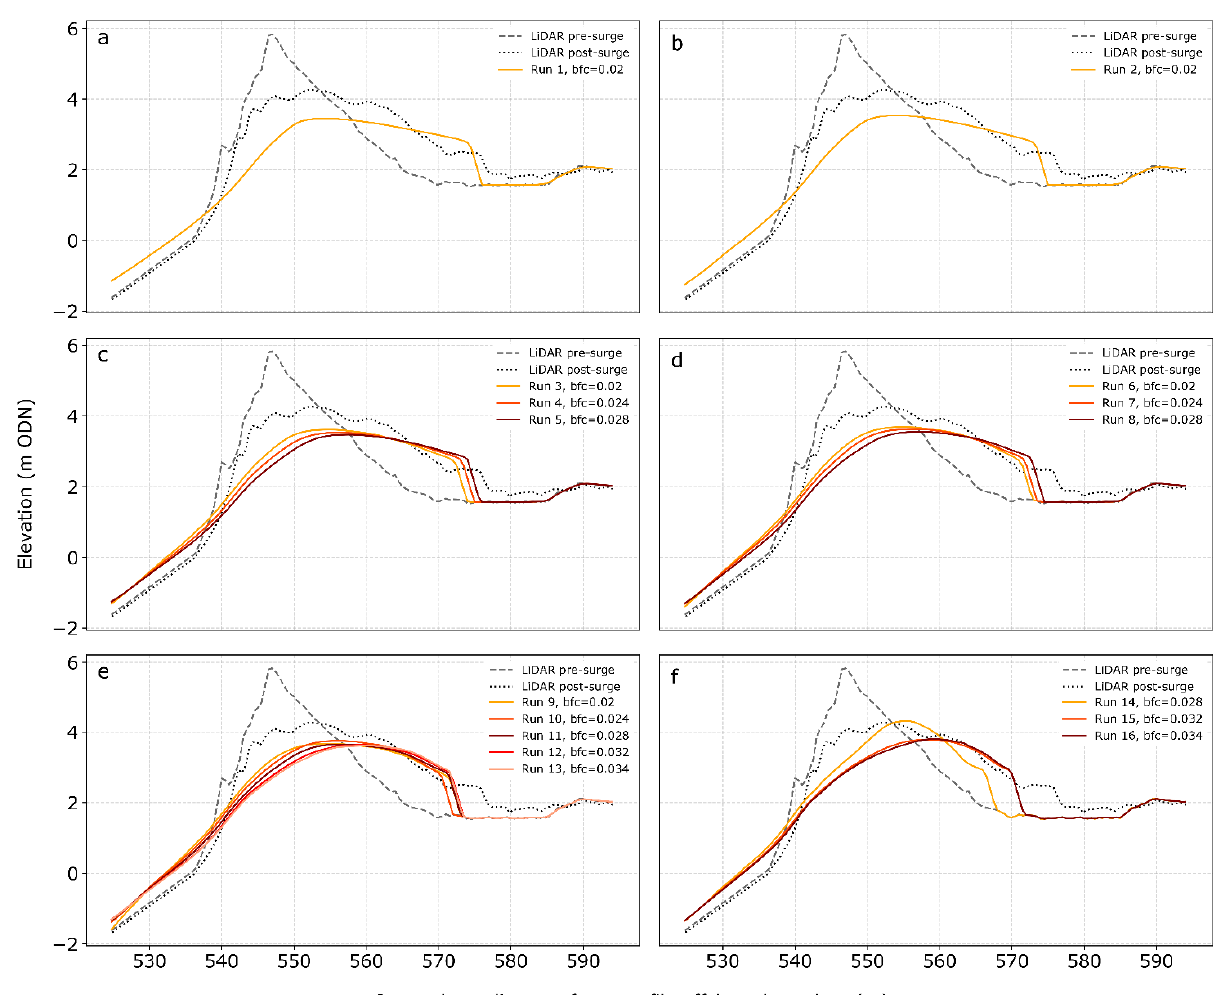
Figure 7. XBeach-G model calibration through systematic variation of free parameters. Modeled cross-shore profiles from the sixteen free parameter combinations are shown grouped by infiltration coefficient (kx) value, subplots ( a–f ), and colored by bed friction coefficient (bfc). The pre- and post-storm cross-shore profiles extracted from LiDAR are also shown. The profiles are orientated left (seaward) to right (landward).